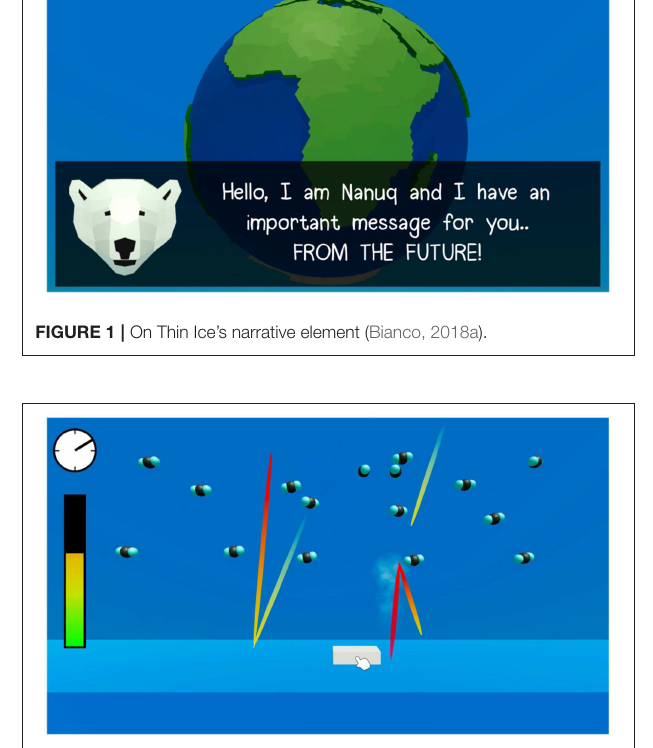
FIGURE 2 | On Thin Ice’s game play element (Bianco,